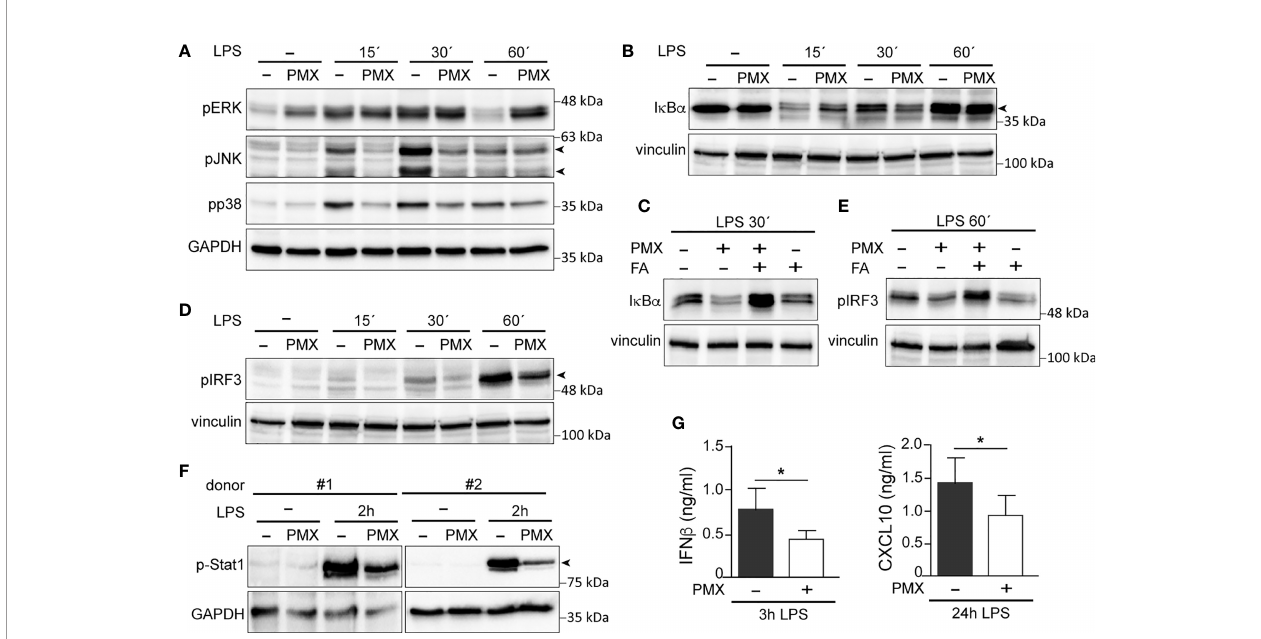
FIGURE 4 | PMX alters TLR4 signaling in GM-CSF-primed macrophages. (A, B) Immunoblot analysis of pERK, pJNK, and pp38 (A) and I k B a (B) by monocytes differentiated with GM-CSF in the absence or presence of PMX for 7 days and challenged with LPS for the indicated time points. (C) Immunoblot analysis of I k B a by monocytes differentiated with GM-CSF in the absence or presence of PMX, PMX+FA or FA for 7 days and challenged with LPS for 30 min. (D, E) Immunoblot analysis of pIRF3 by monocytes differentiated with GM-CSF in the absence or presence of PMX (D) , folinic acid (FA), or both (E) for 7 days and challenged with LPS for the indicated time points. (F) Immunoblot analysis of pStat1 by two independent preparations of monocytes differentiated with GM-CSF in the absence or presence of PMX for 7 days and challenged with LPS for 2 h. In panels (A – F) , a representative experiment of two to four independent donors is shown. Molecular weight markers are indicated. Arrowheads indicate the protein of interest. (G) Production of IFN b and CXCL10 by monocytes differentiated with GM-CSF in the absence or presence of PMX challenged with LPS for 3 h (IFN b ) or 24 h (CXCL10), as determined by ELISA. Mean ± SEM of seven independent donors are shown (* p < 0.05). PMX, pemetrexed; GM-CSF, granulocyte-macrophage colony-stimulating factor; LPS,